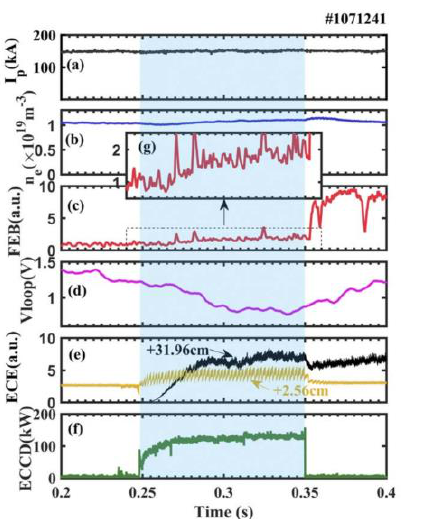
Fig. 10. Temporal evolution of typical on-axis ECCD experiment which generated a large number of fast electrons [15]. From the top to bottom, the waveforms are: (a) the plasma current, (b) the central line averaged electron density, (c) FEB signal at the radial position of 0 cm (from demodulator), (d) the loop voltage, (e) ECE signals at the radial position of +2.56 cm and +31.96 cm (out of plasma), (f) ECCD power. About 150 kW EC wave power is injected into plasma from 250 ms to 350 ms and (g) the enlarged FEB signal of dashed